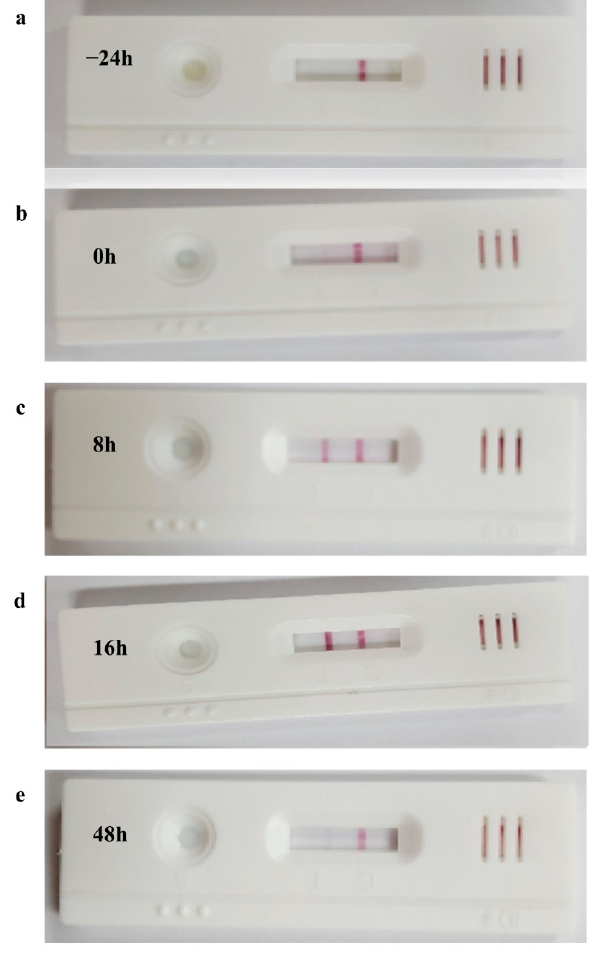
Figure 3. Estrous discrimination using bovine heat detection kit during estrous synchronization, ( a ) 24 h before the second GnRH injection; ( b ) at the time of the second GnRH injection; ( c – e ) at 8, 16, 48 h after the second GnRH injection, respectively.